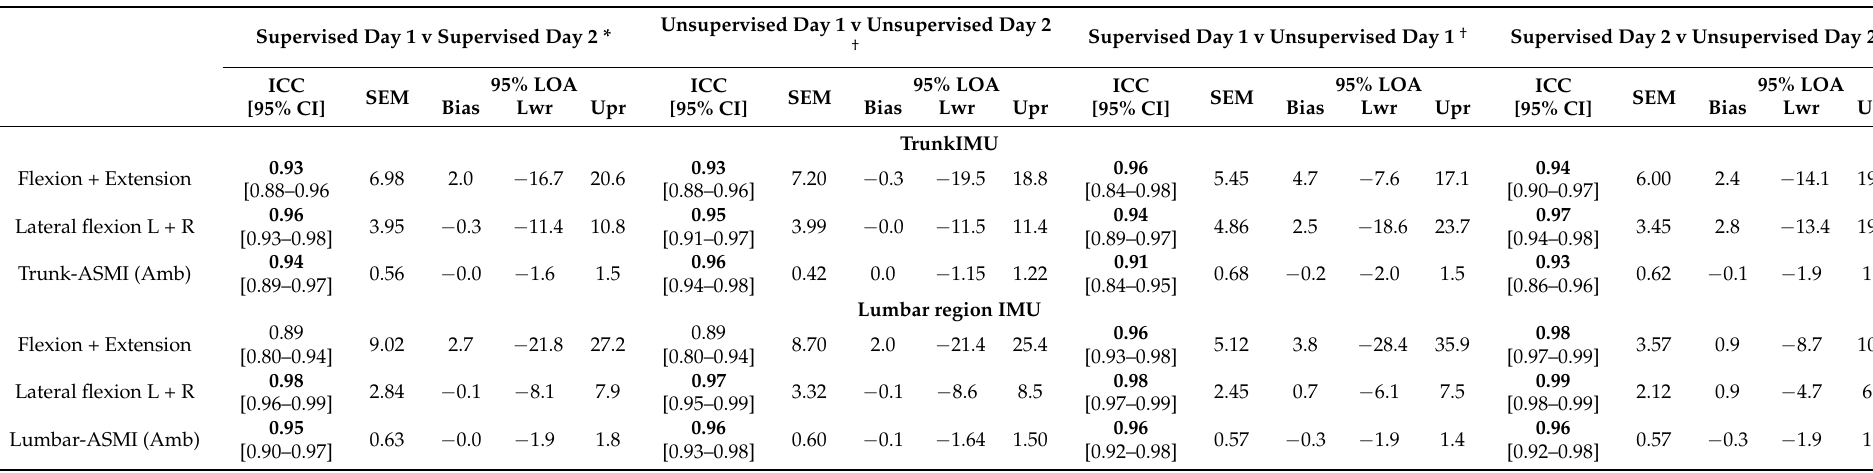
Table 5. Test-retest reliability and agreement of full-arc movement measurements and composite – ASMI (Amb) scores under supervised and unsupervised conditions in the